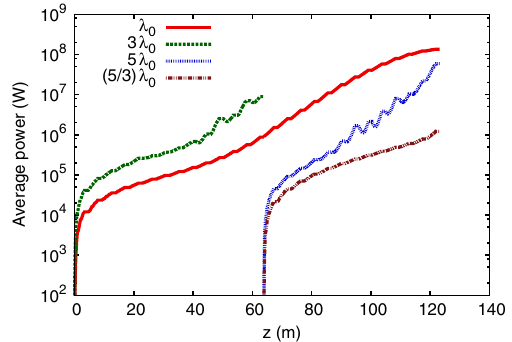
FIG. 3. Average power produced at various wavelengths as a function of distance for the nominal example.